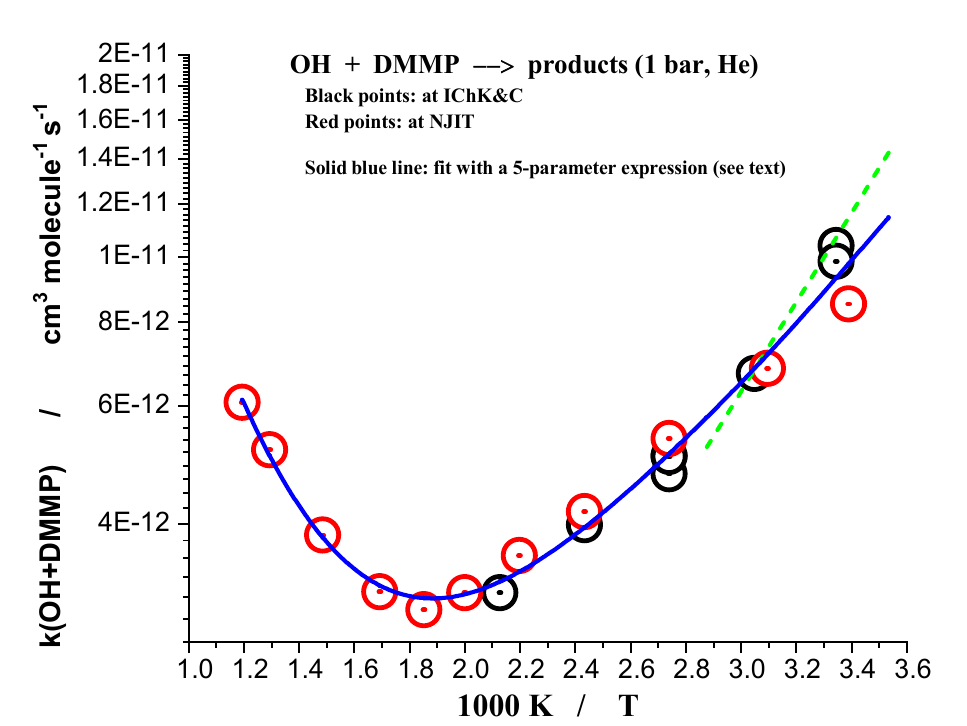
Figure 4. Summary. Rate constant of reaction (1) at 1 bar, over the temperature range 298–837 K. Red points: N 2 O/H 2 O/He + 193 nm, (at NJIT), black points: O 3 /H 2 O/He + 266 nm, (at ICKC). Blue line—fit by a 5-parameter expression (see text). Green dotted line: the only previous indirect experimental determination (relative rates method [13]).